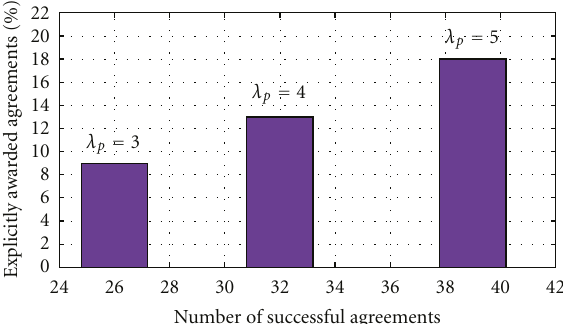
Figure 15: Explicit spectrum sharing agreements.